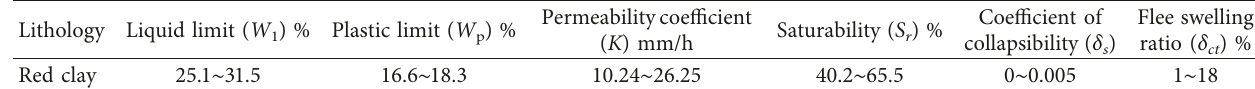
Table 2: The water-physical property of red